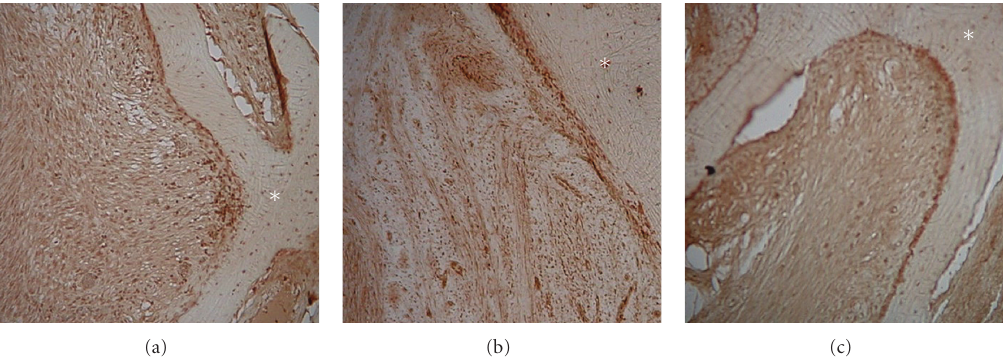
Figure 4: Immunohistochemistry for bone morphogenic protein (BMP; x100 magnification). (a) BMP-2, (b) BMP-4, and (c) BMP-7. The tumor cells stained positive for BMP-4 and negative for BMP-2 and BMP-7. ∗ asterisk: bone